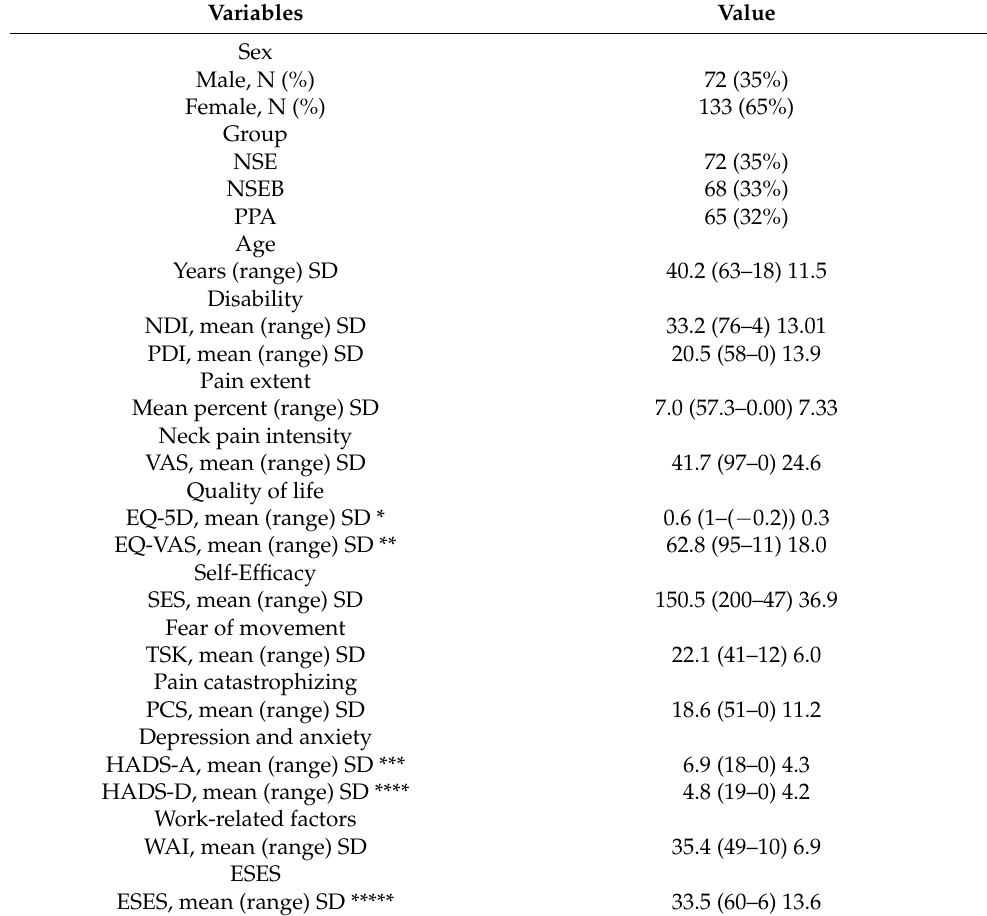
Table 1. Baseline characteristics of the included participants with chronic WAD ( n = 205).